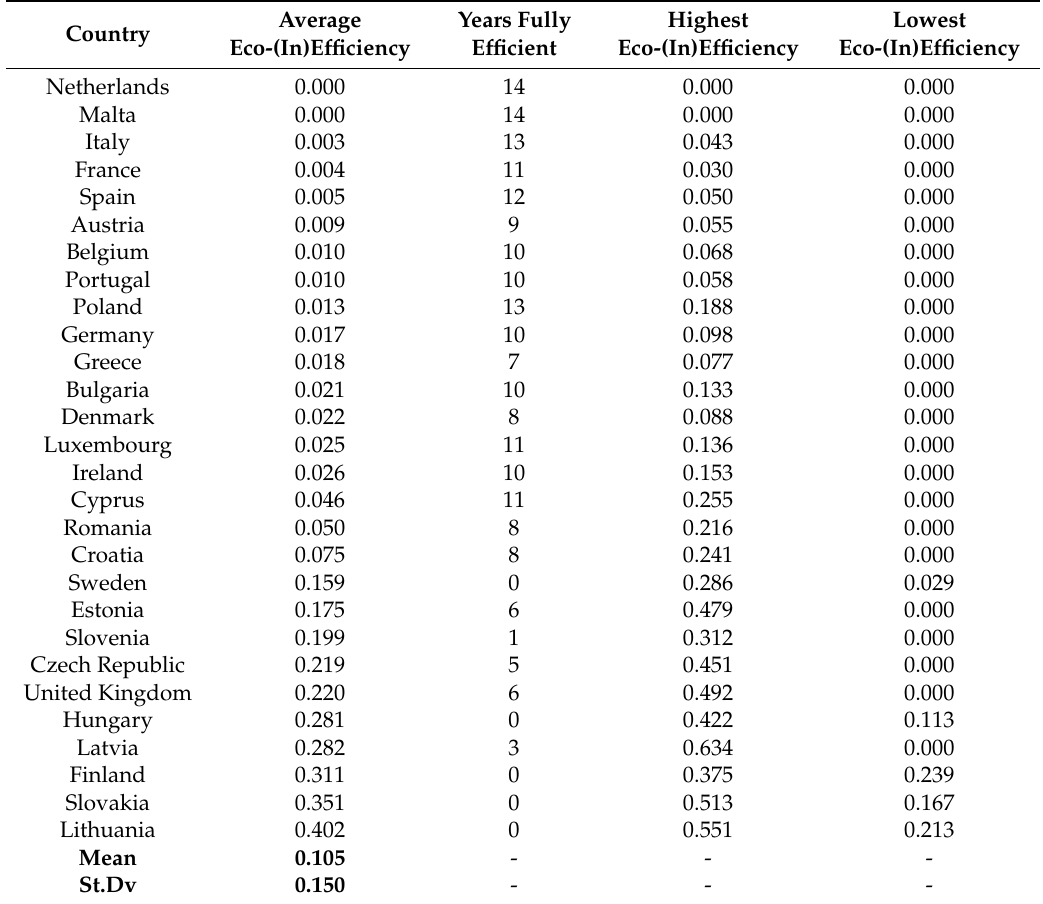
Table 2. Eco-(in)efficiency scores and longitudinal performance in EU agricultural sector